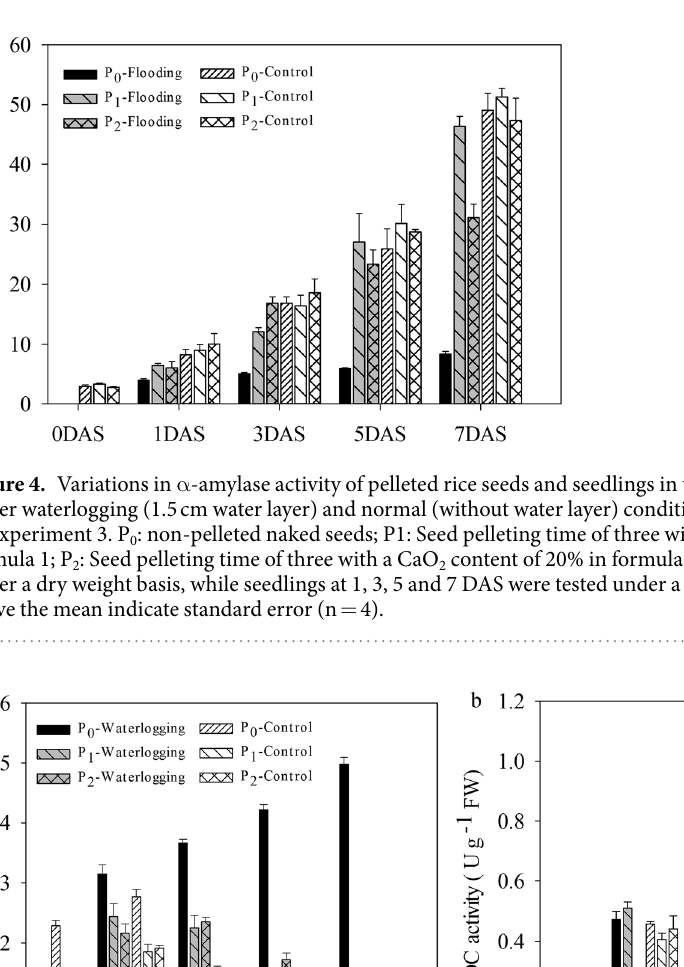
were consistent with the results from the growth chamber experiments. On average, the germination percentages of the two pelleting treatments were 33.75% higher than the naked seeds. The shoot length, root length, shoot fresh weight, and root fresh weight in the pelleting treatments were increased by 65.06%, 33.86%, 172.61%, and 182.53%, respectively, compared with naked seeds control.